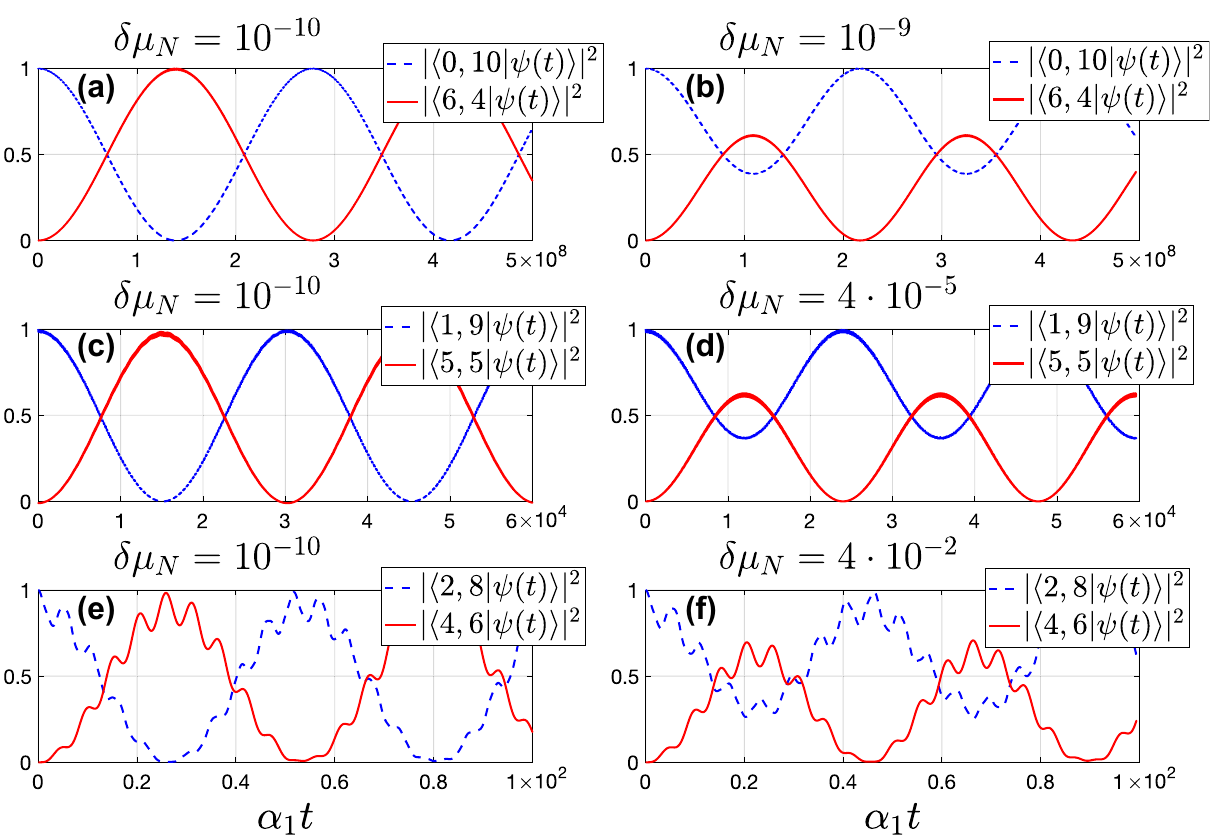
ψ( t ) solving the Schrodinger equation with the initial condition | � n , N n m n , N m n and are shown for ( a , b ) n | � | � − − − + 1 , � 4 , g /α 1 µ N (α 1 α 2 )/ 2 α 2 N = = + − ≈ −